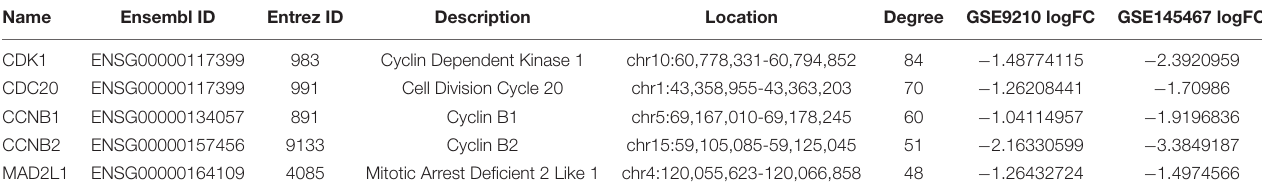
TABLE 3 | Basic information of hub